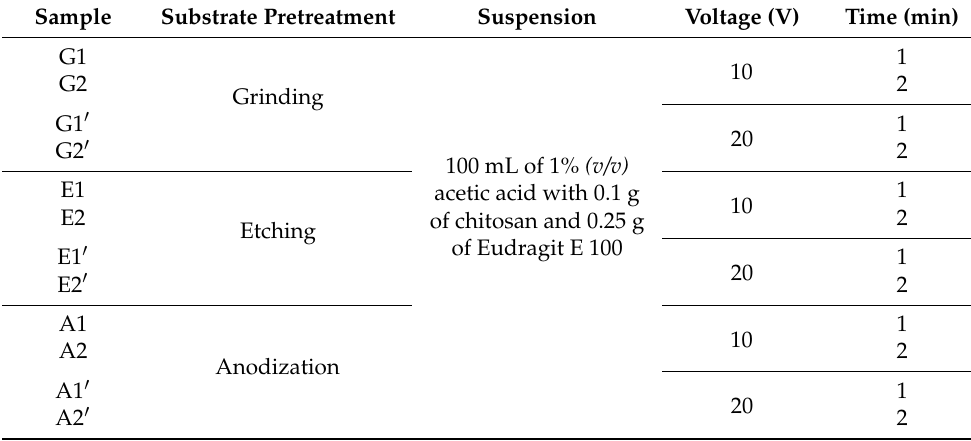
Table 2. Designations of experiment samples with the applied process